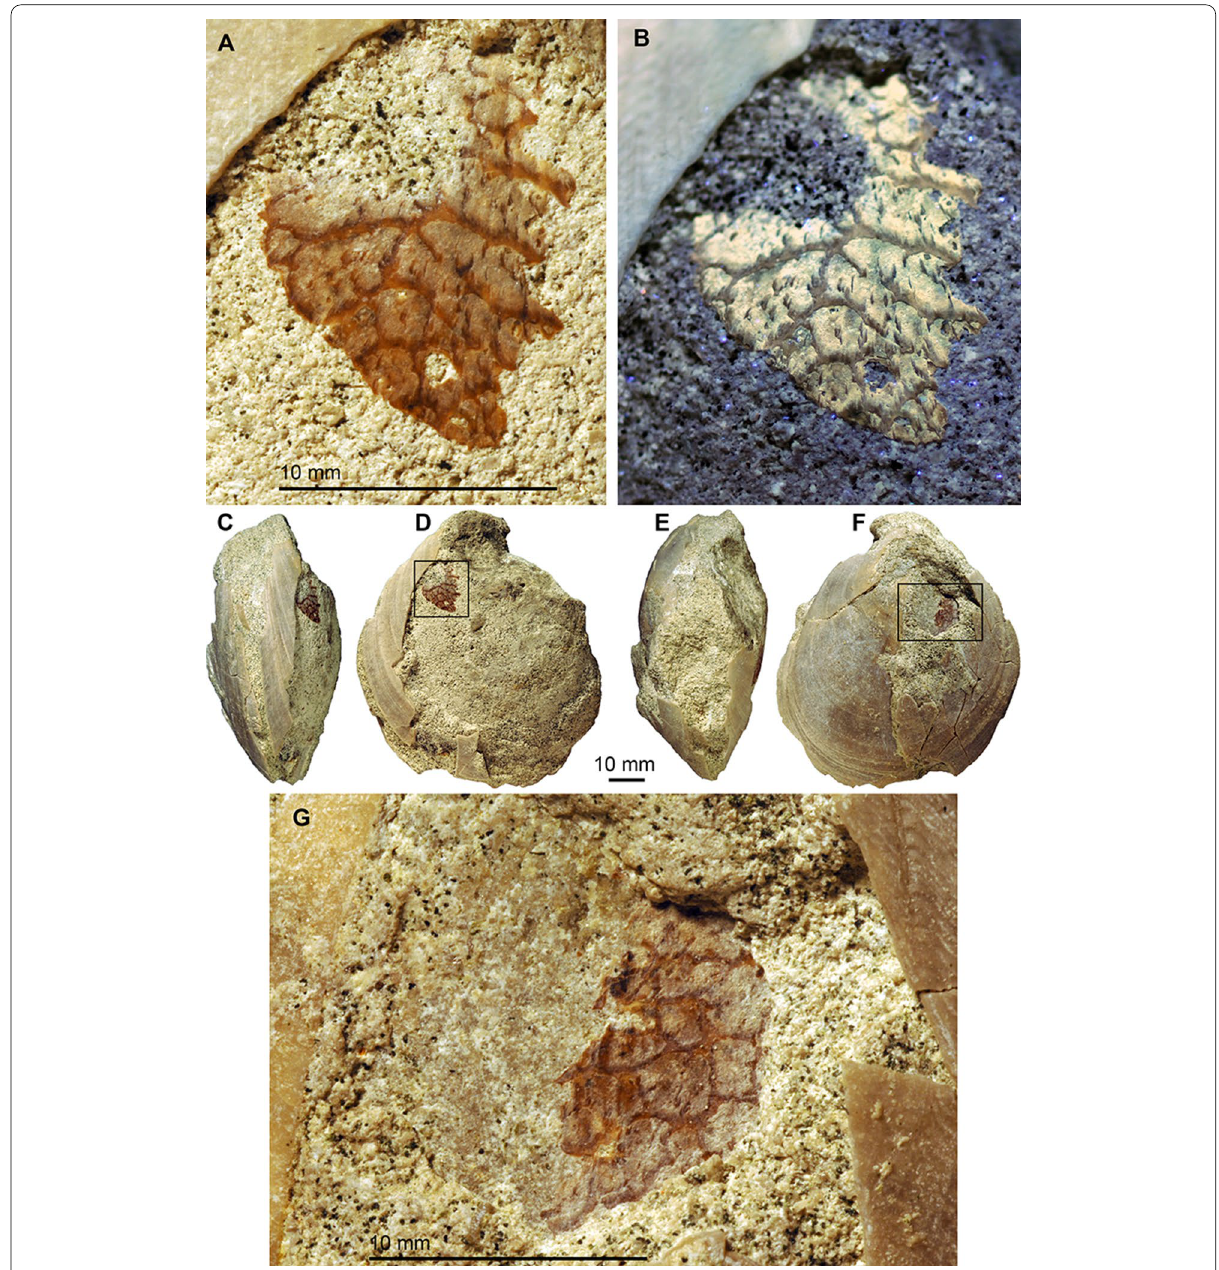
Fig. 2 Acesta clypeiformis (d’Orbigny, 1847) with adductor muscle scars retaining phosphatized muscle remains. Cenomanian, Falaises des Vaches Noires, France. B taken under UV-light, A , B adductor muscle of the right valve (marked with a rectangle in D). C – F Photos of the entire specimen. C Anterior; D right; E posterior; F left view. G Adductor muscle of the left valve (marked with a rectangle in F